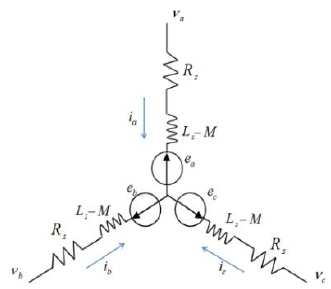
Figure 2. Equivalent circuit of the PMSM.